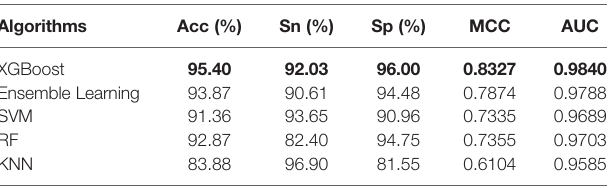
TABLE 3 | The prediction results of different classi fi ers for predicting pupylation proteins.